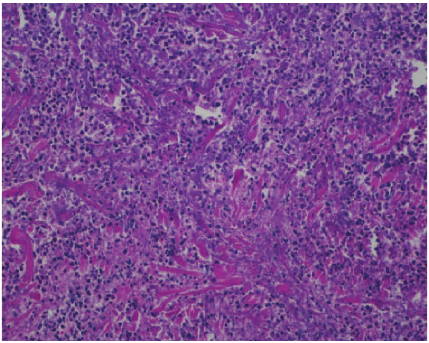
Figure 4: Perivascular inflammation.